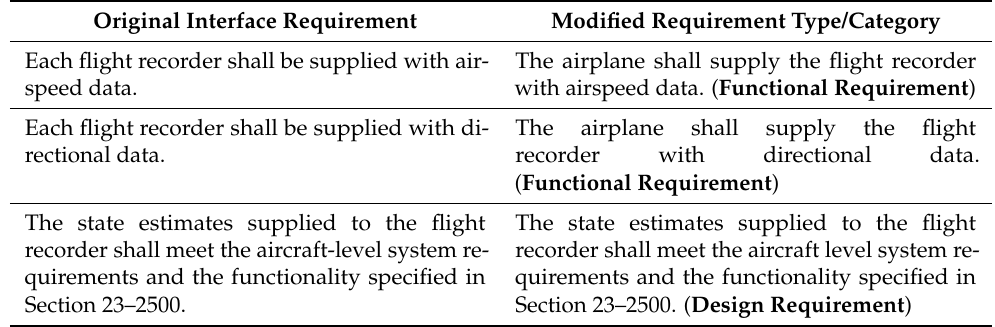
Table 6. Examples showing the modification of Interface requirements into other types of